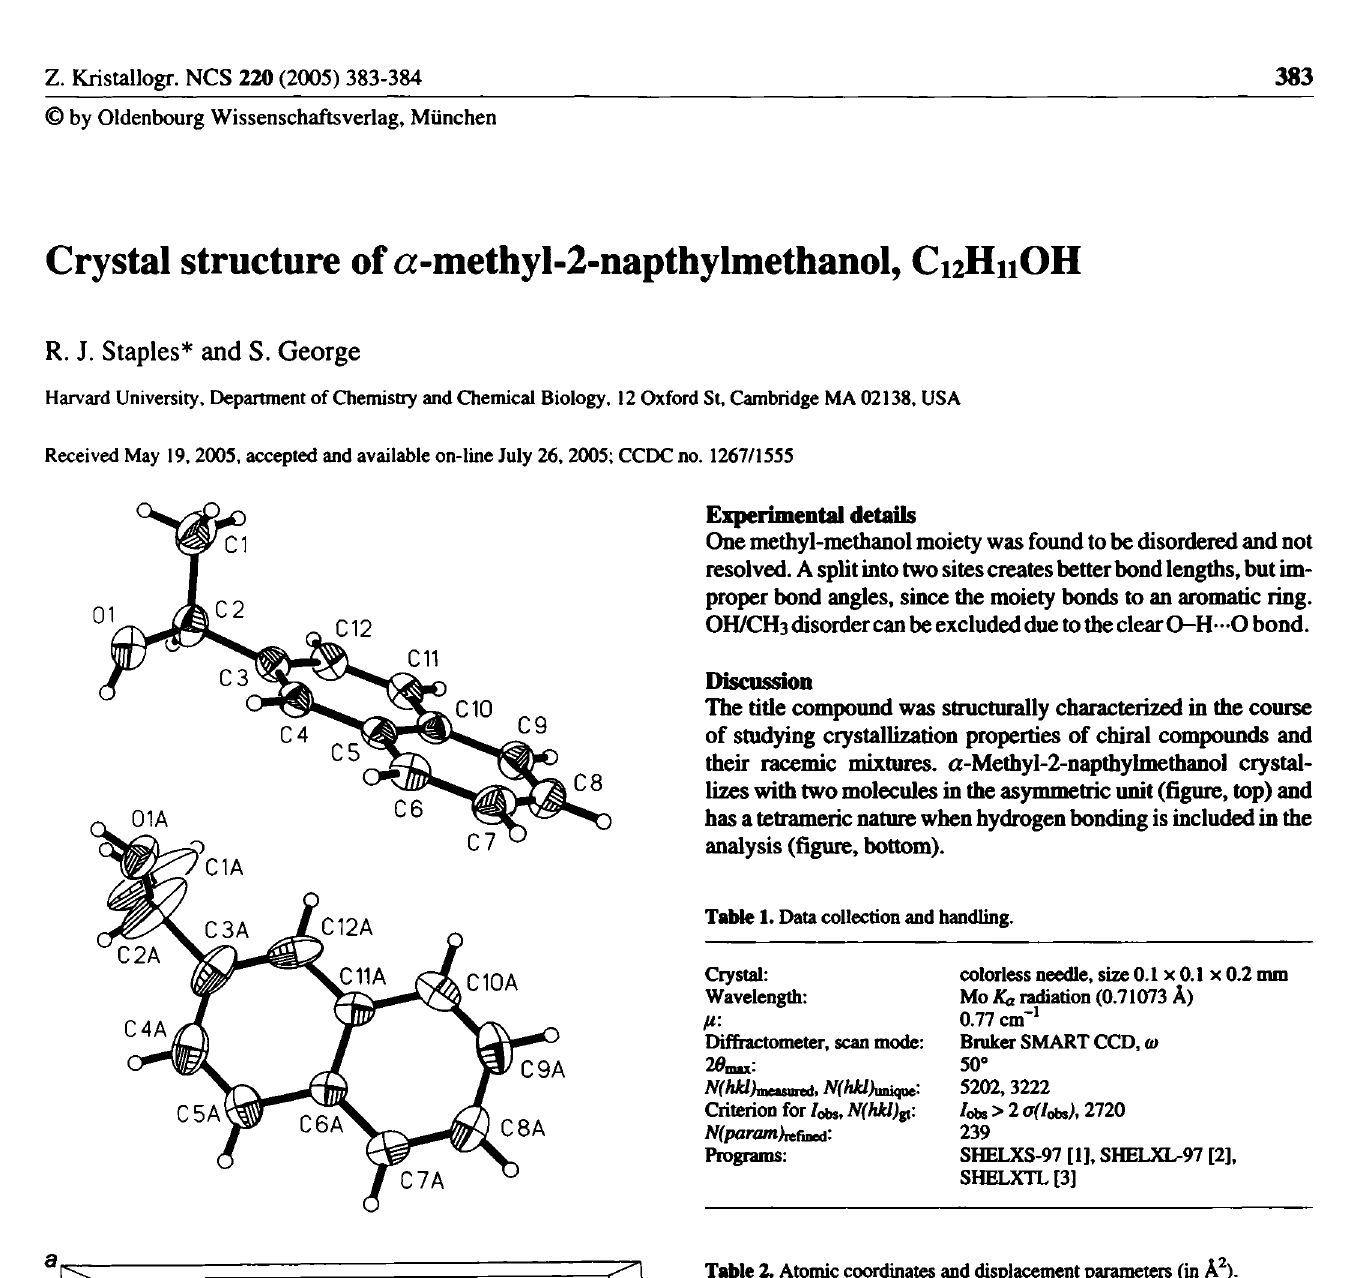
Table 2. Atomic coordinates and displacement parameters (in Ä 2